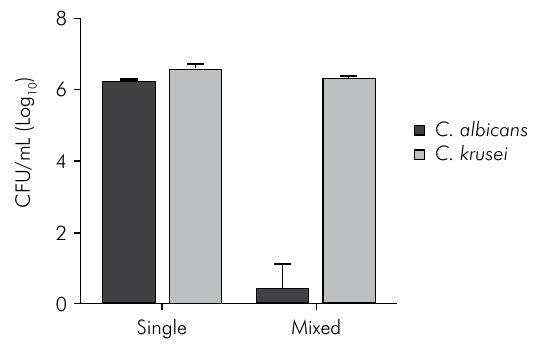
Figure 3. Mean values and standard deviation (n = 10) of CFU/mL (log ) of C. albicans and C. krusei , organized 10 in single and mixed biofilms. Student t-test. C. albicans counts: statistically significant difference between biofilm formed by C. albicans and biofilm formed by C. albicans + C. krusei (p < 0.0001). C. krusei counts: statistically significant difference between biofilm formed by C. krusei and biofilm formed by C. albicans + C. krusei (p < 0.0001).